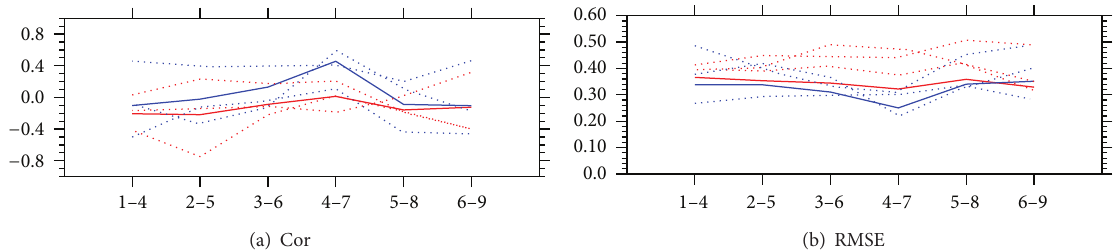
Figure 10: The same as Figures 3(a)-3(b), but for Mega-ENSO index. Mega-ENSO index is defined as the difference in area-averaged SST anomalies between the western K-shape zone and the eastern triangle zone in Figures 9(a) and